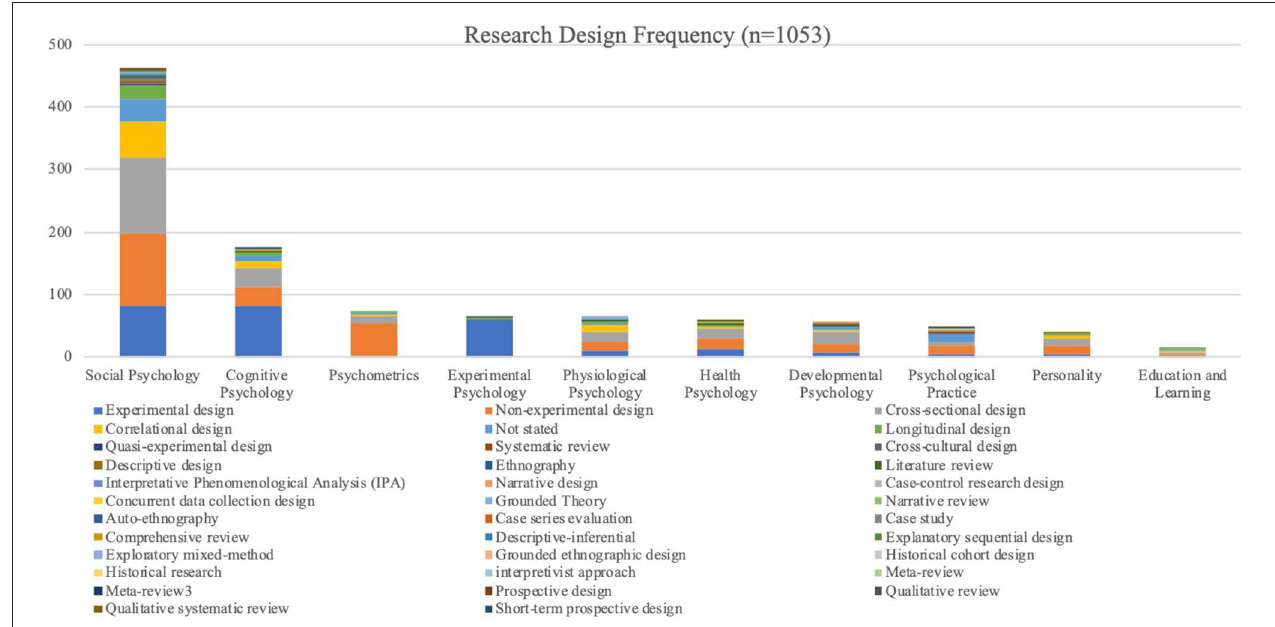
FIGURE 6 | Design frequency in